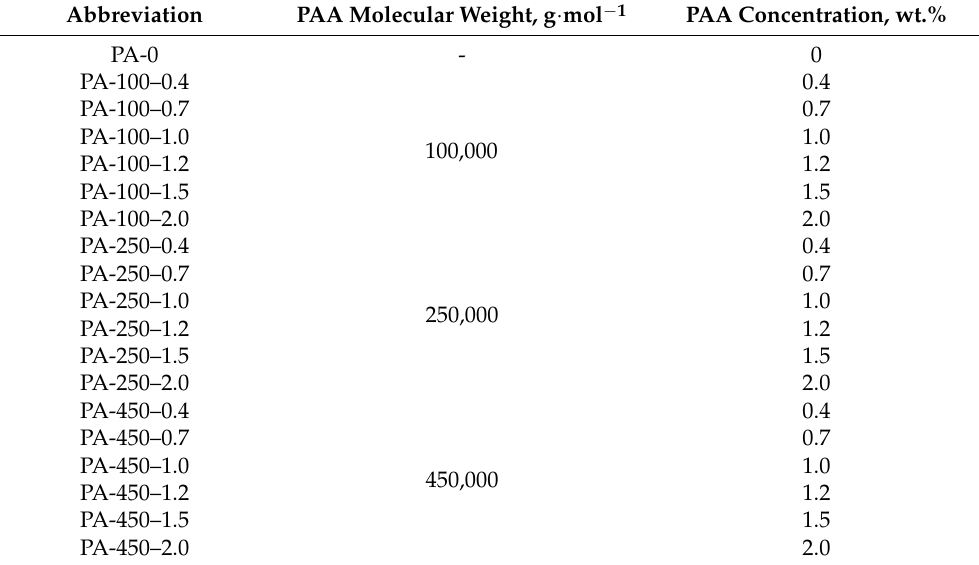
Table 1. Abbreviations of PSF ultrafiltration membranes obtained using PAA aqueous solutions as coagulation